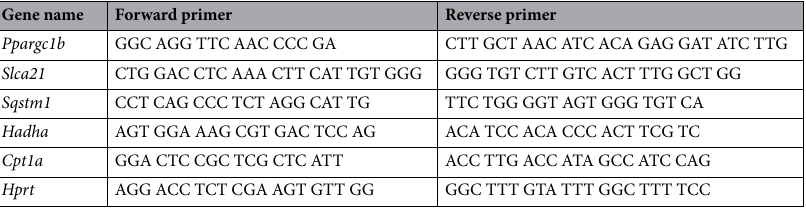
Table 1. List of primers used for